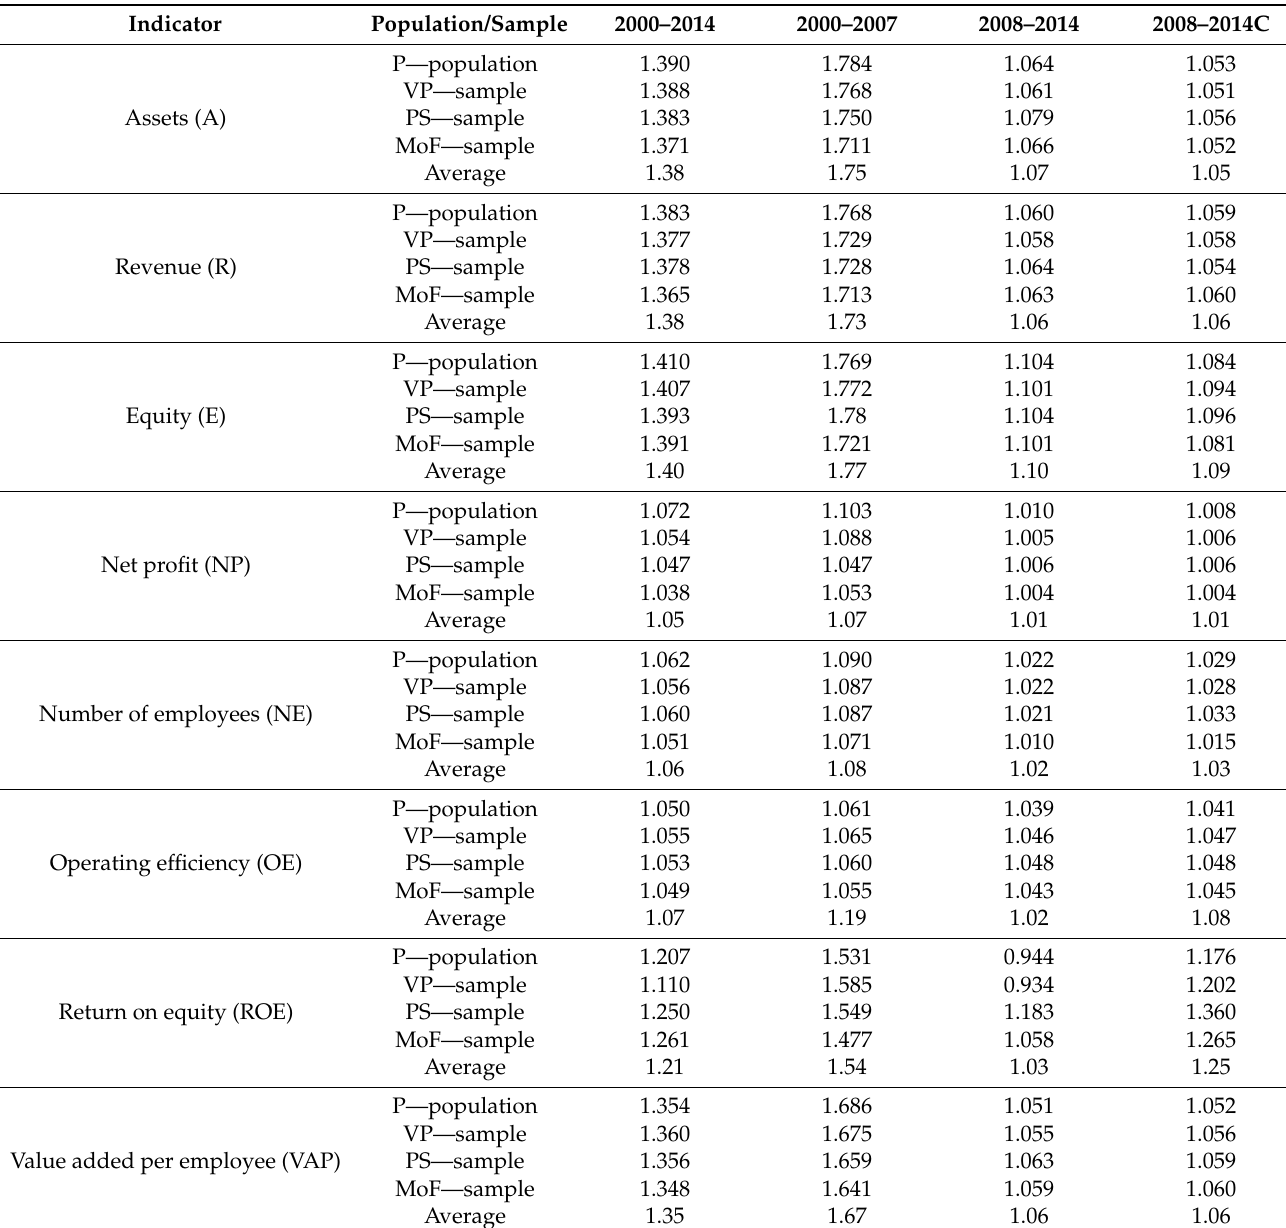
Table 1. Economic and financial indicators indices for the population of enterprises and sample groups of enterprises in different